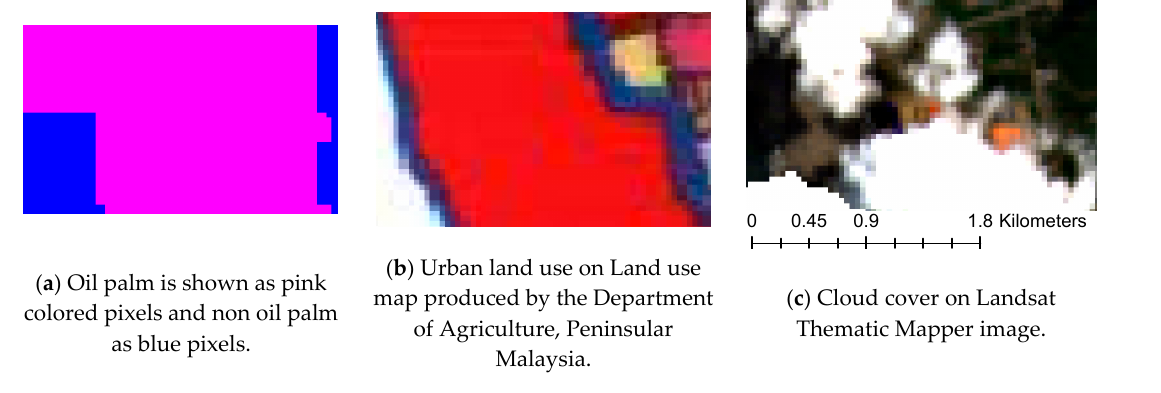
Figure 6. ( a ) Misclassified built up area as oil palm; ( b ) land use map; and ( c ) Landsat 8 image.